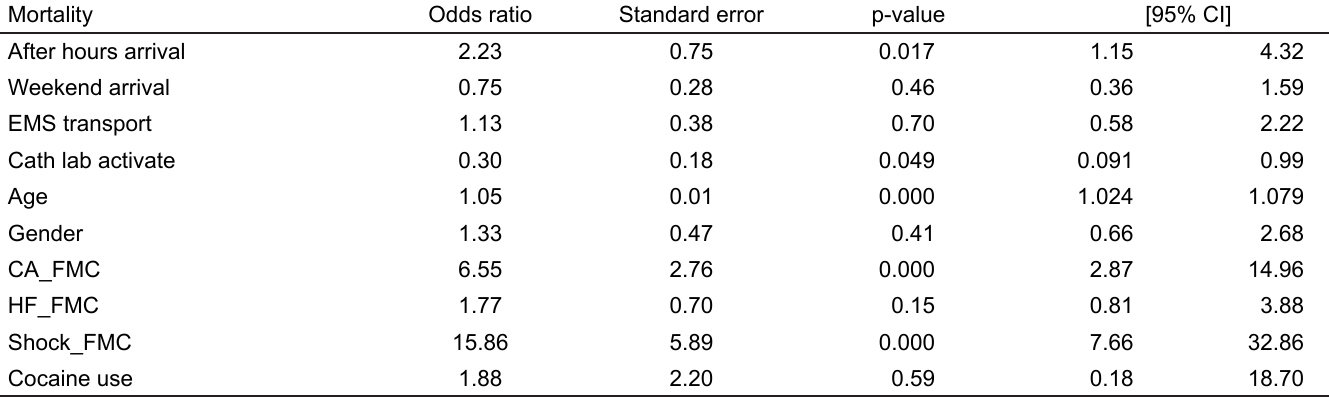
Table 2. In-hospital mortality based on patient arrival on weekends or holidays vs. on non-holiday weekdays.